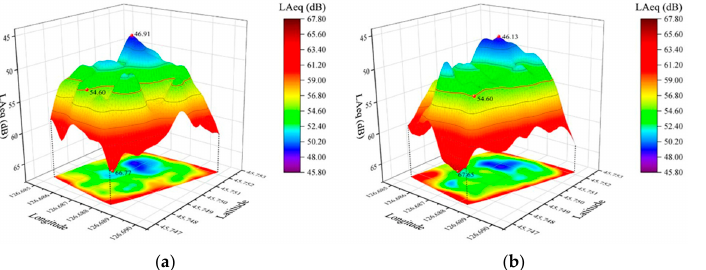
Figure 4. Three ‐ dimensional map of sound pressure level distribution. ( a ) 8:00–10:00 a.m., and ( b ) 14:00–16:00 p.m.